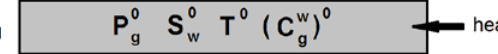
Fig. 7. The heatpipe effect problem statement.